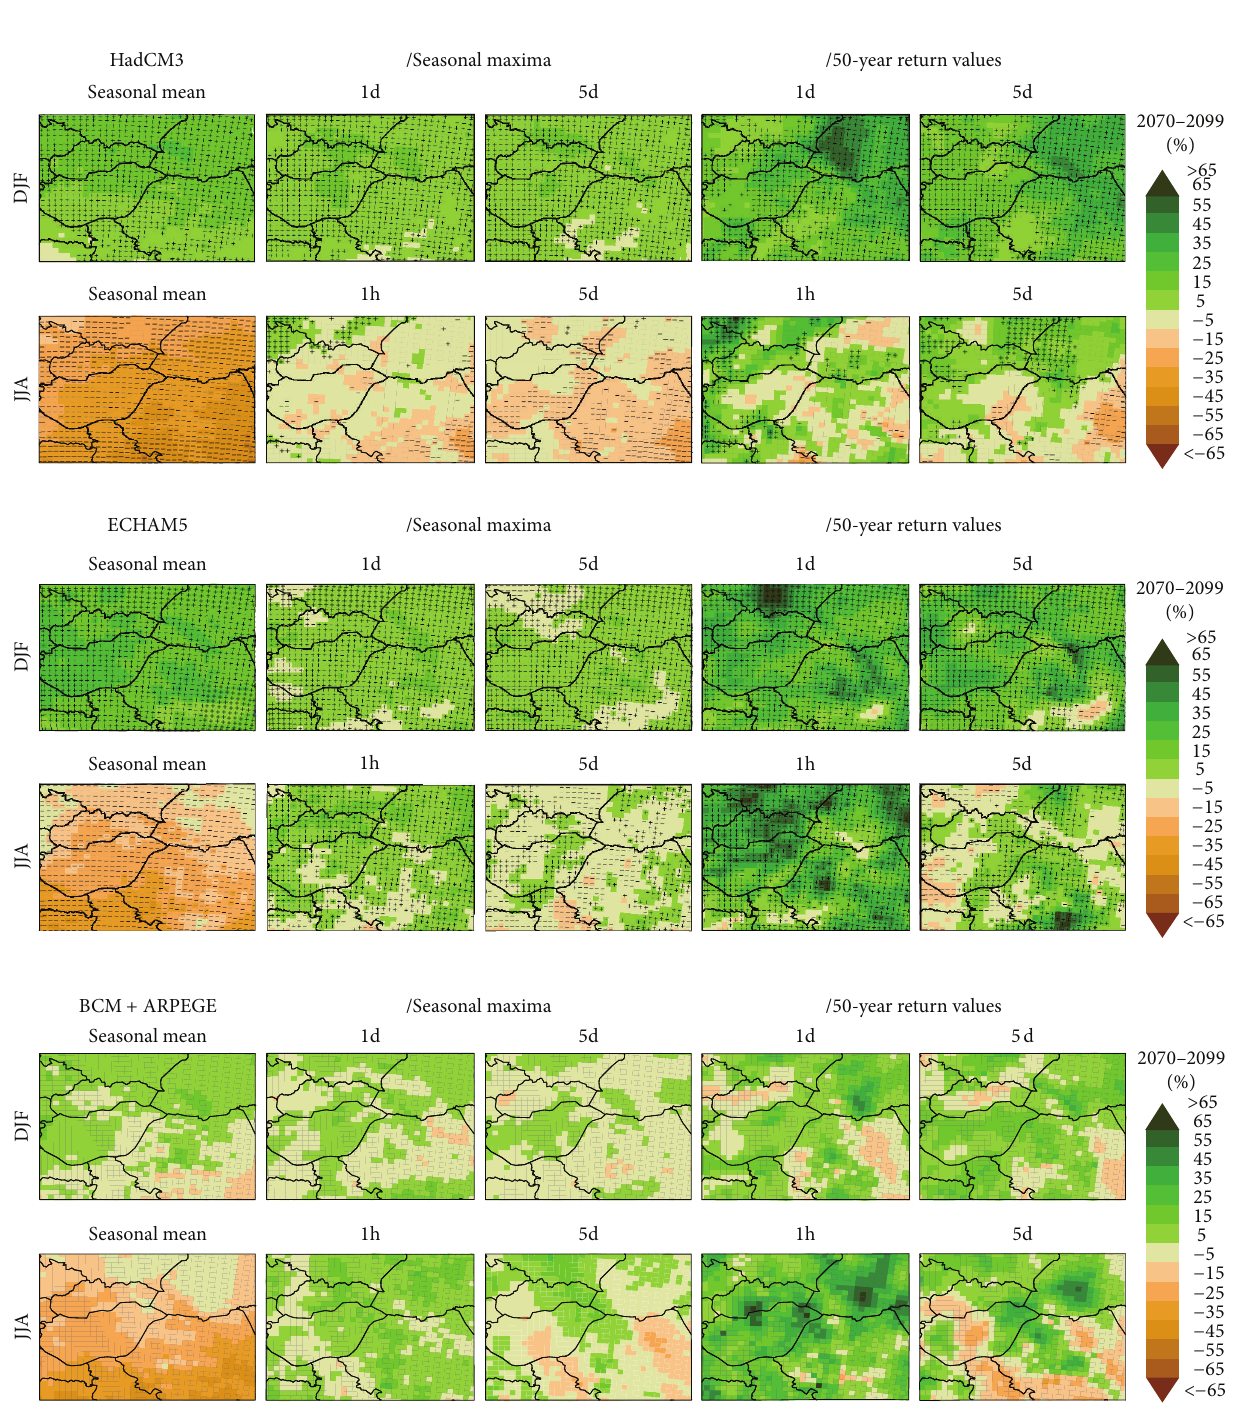
Figure 4: Ensemble mean of the projected relative changes (in %) for the late 21st century (2070–2099) in comparison with the control period (1961–1990), for different driving GCMs: 6 RCMs driven by HadCM3 (top), 4 RCMs driven by ECHAM5 (middle), and 2 RCMs driven by BCM and ARPEGE (bottom). Same variables as in the case of the two previous figures are displayed, that is, the mean seasonal precipitation, mean seasonal maxima of 1-hour/1-day and 5-day precipitation, and 50-year return values of 1-hour/1-day and 5-day precipitation assessed by the pooling (ROI) approach. Signs “+/ − ” in the case of HadCM3 (ECHAM5) ensemble indicate grid boxes where at least 5 (3) of the 6 (4) RCMs agree on the sign of change for the given precipitation characteristic. For further details and explanation, see